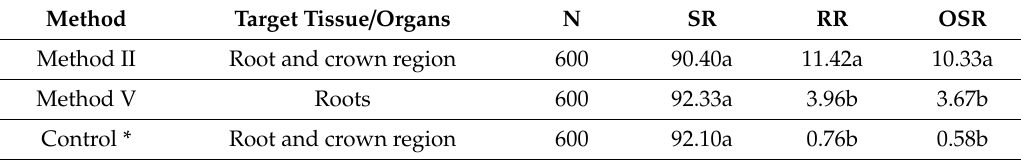
Table 3. Comparison of success rates recorded from Methods V and II of colchicine application to haploid seedlings. Control was treatment as in Method II but colchicine was replaced by tap